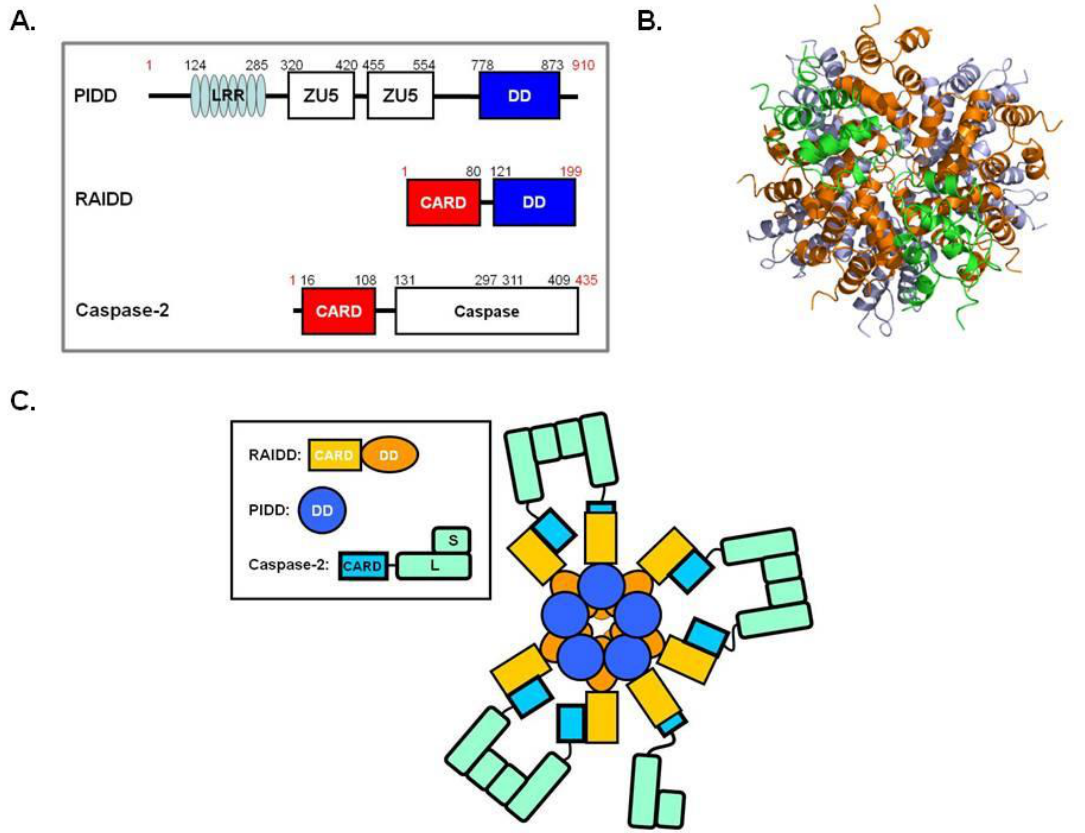
Figure 4. ( a ) Domain organization of the PIDD, RAIDD, caspase-2, which is the PIDDosome component; ( b ) Overview of the RAIDD DD: PIDD DD complex structure (Top view). The top layer contains two RAIDD DD (green color), the middle layer contains five RAIDD DD (orange color), and bottom layer contains five PIDD DD (light blue color) (PDB id: 2OF5); ( c ) A model of the PIDDosome for caspase-2 activation. Caspase-2